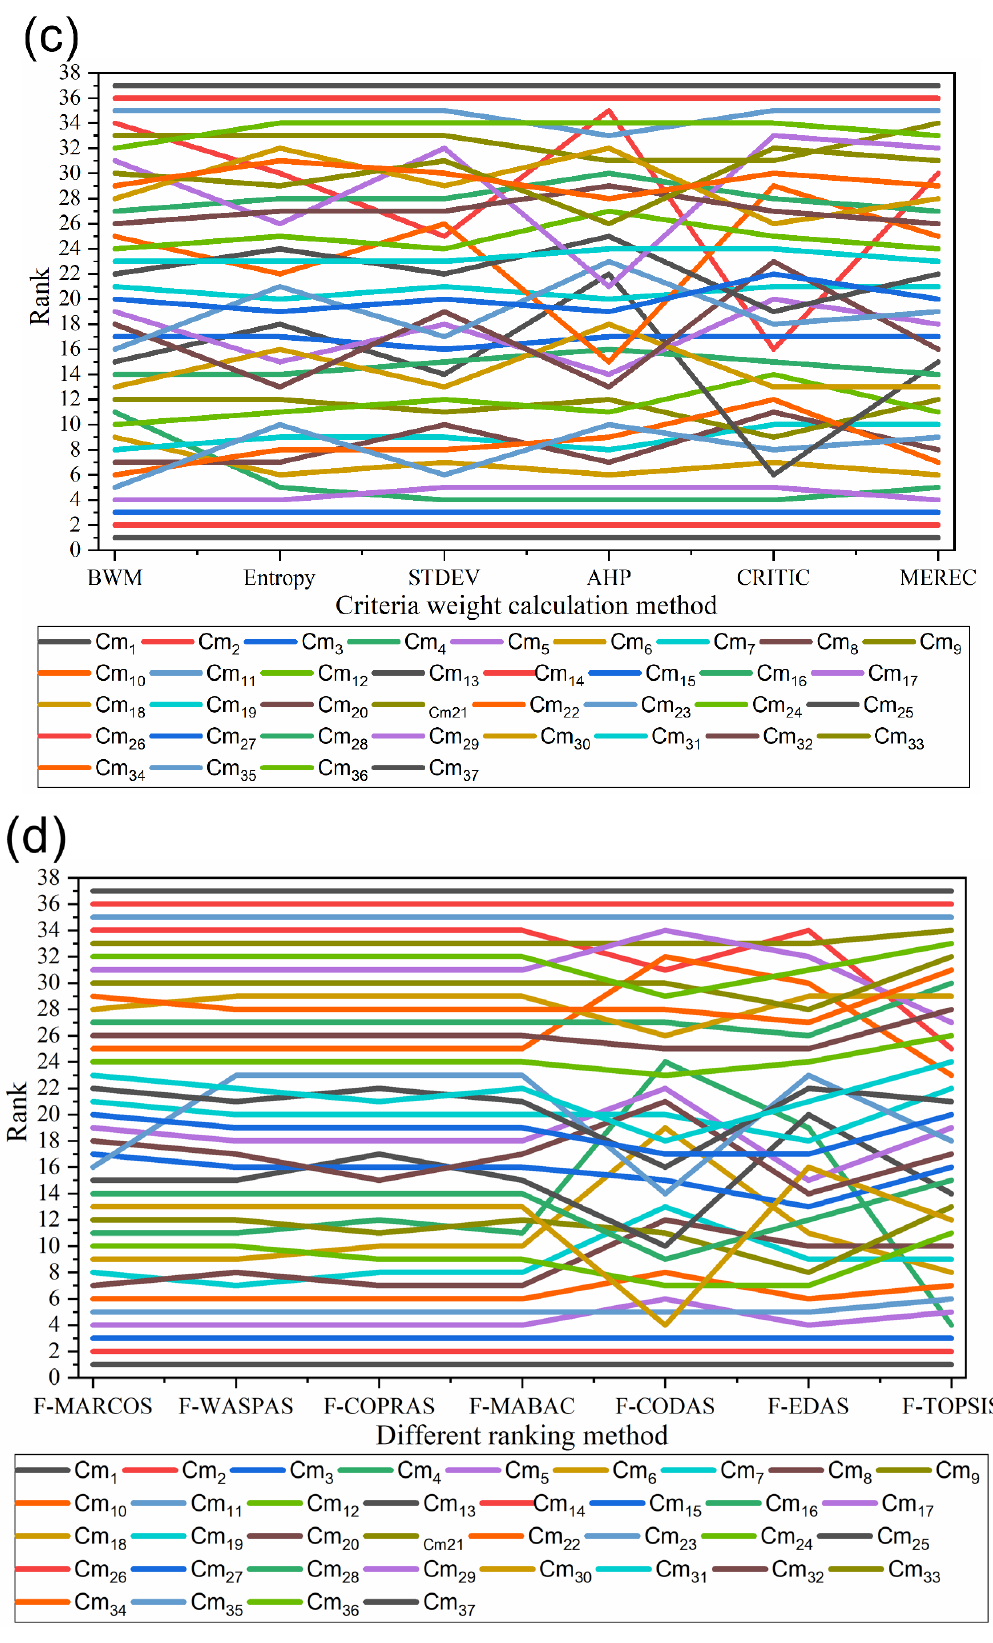
Figure 6. Results of sensitivity analysis ( a ) effect of criteria weight change, ( b ) effect of dynamic matrices, ( c ) effect of different criteria weight calculation method, and ( d ) comparison with other MADM